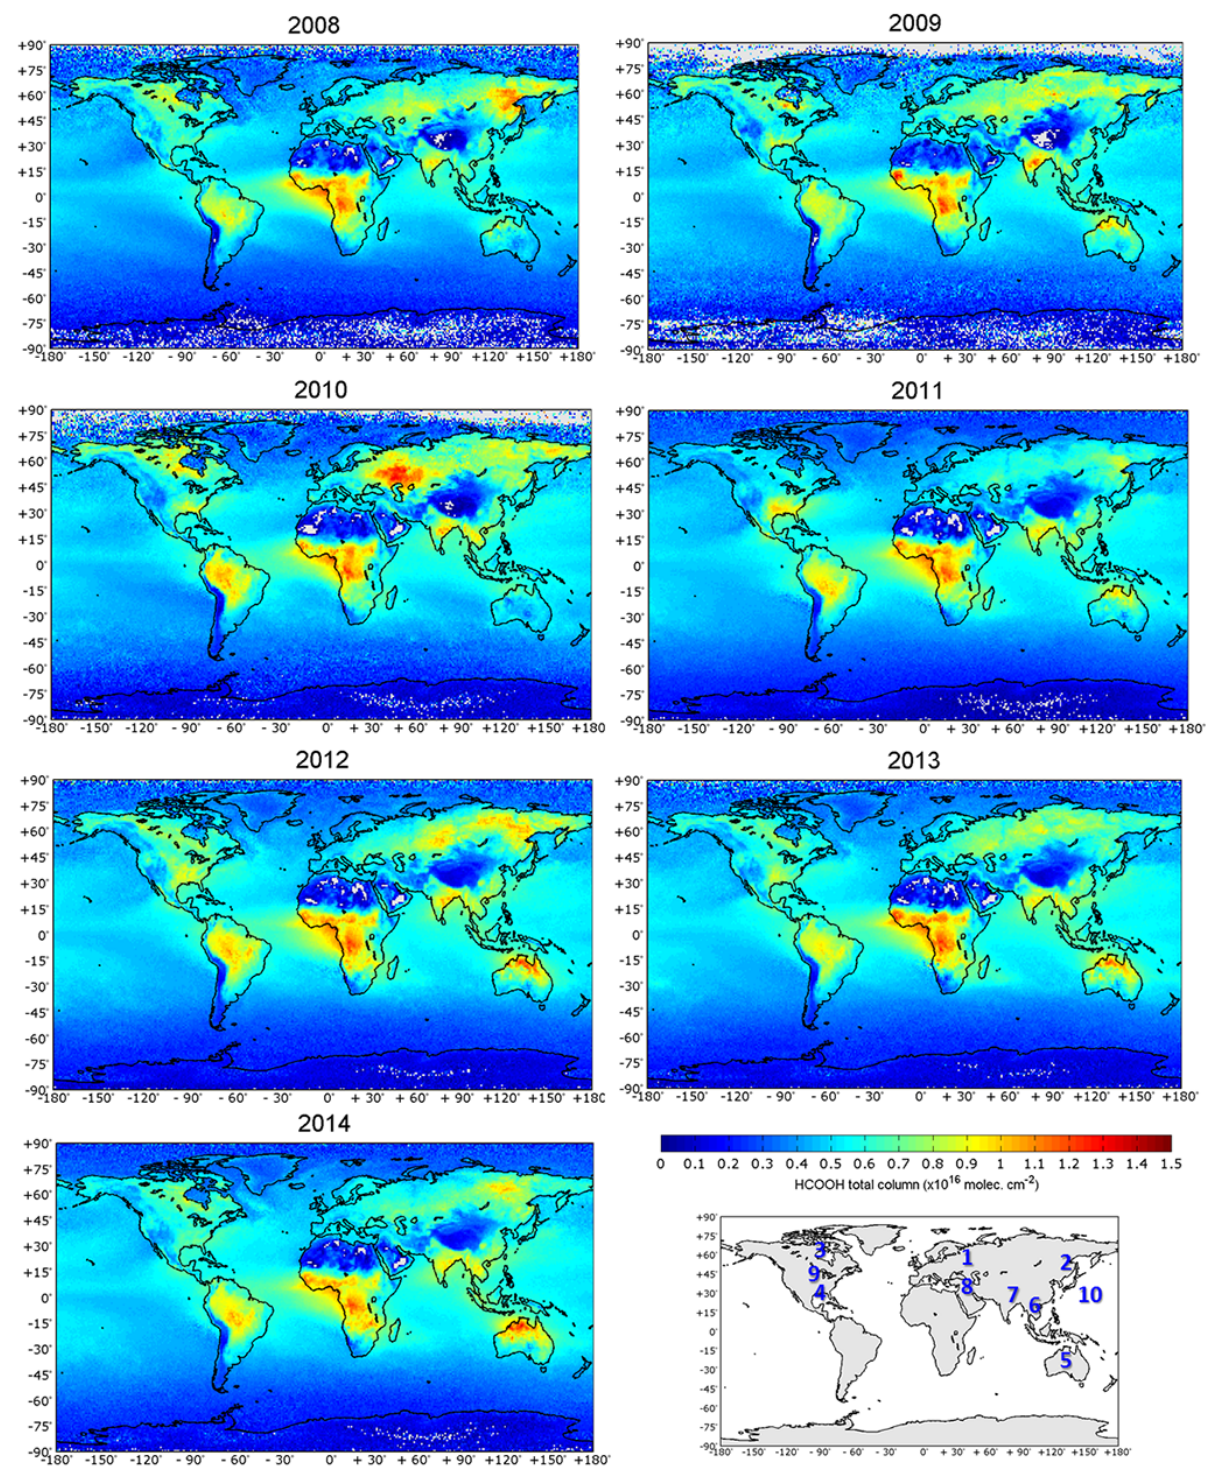
Figure 8. Annual HCOOH global distribution from 2008 to 2014, derived using the IASI radiance observations on a 1 ◦ × 1 ◦ grid. Different sources or distributions described in the text are numbered in blue on the bottom-right